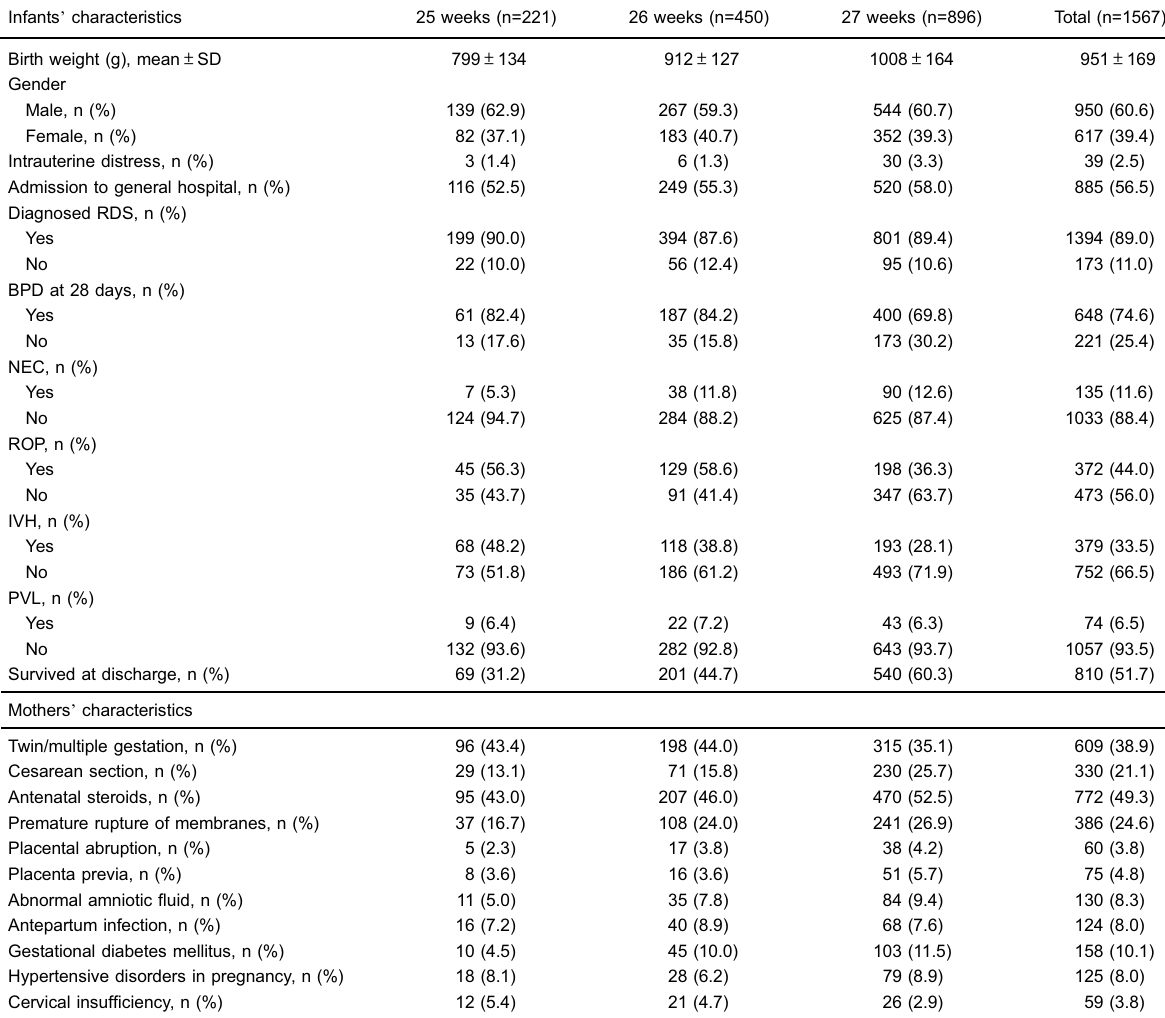
Table 1. Population characteristics of the included infants and